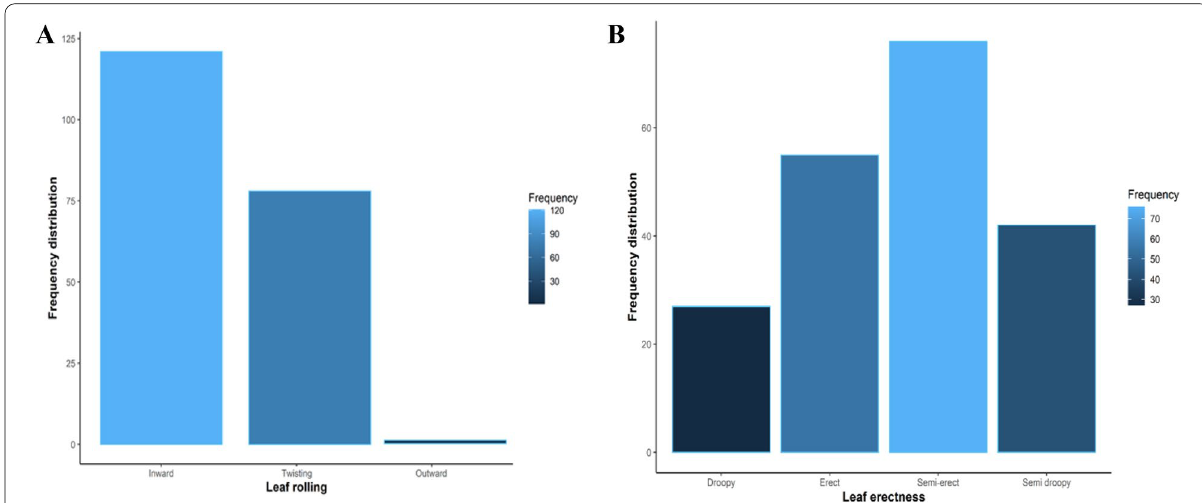
Fig. 2 Genotypic frequency distribution of 200 wheat genotypes for leaf surface traits i.e. leaf rolling ( A ) and leaf erectness ( B )